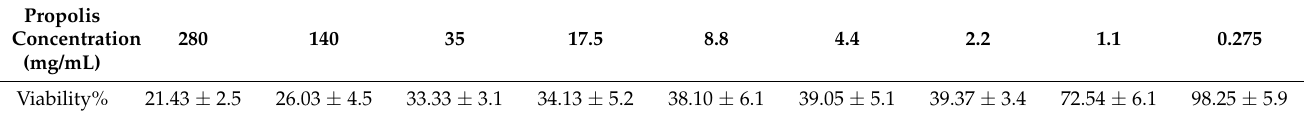
Table 4. The mean viability percentage of Hep-2 cells treated with decreasing concentrations of propolis for 24 h. Propolis Concentration